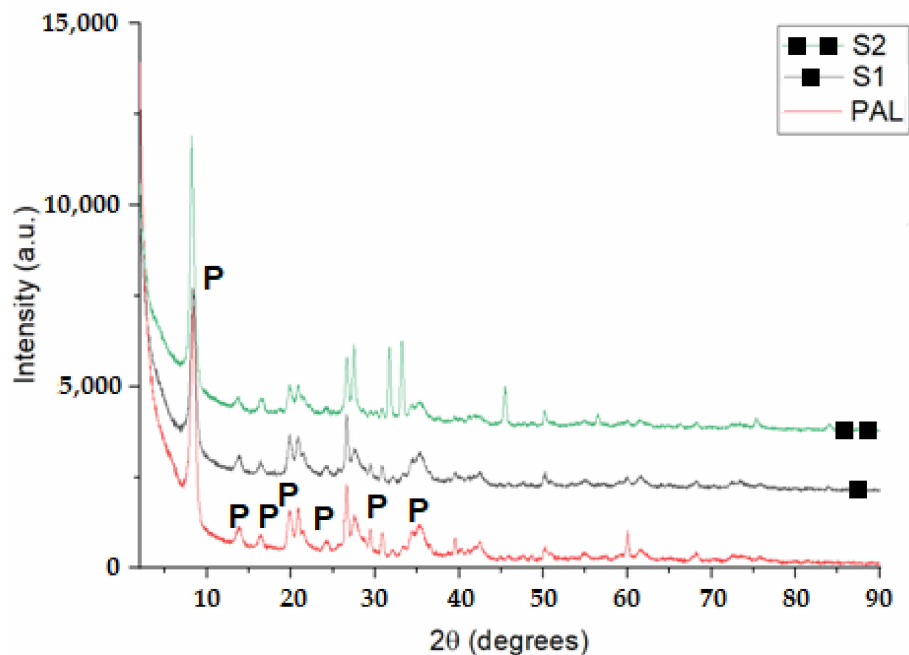
Figure 3. XRD patterns of the support materials.